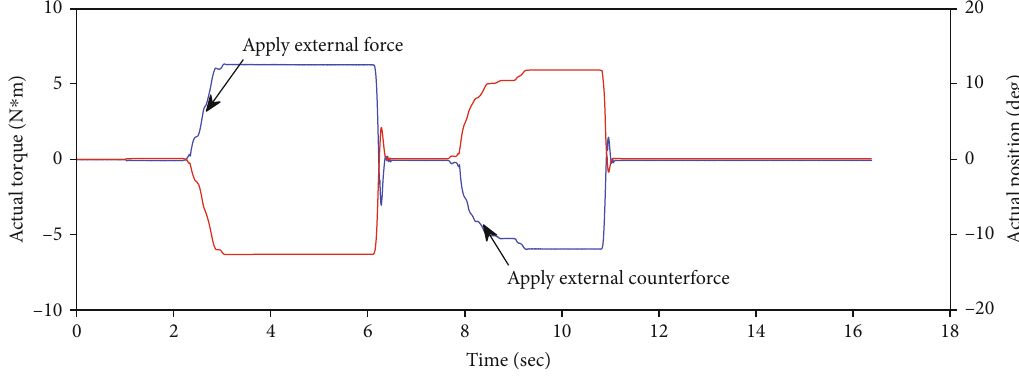
Figure 11: The actual torque and position of the hip joint change after applying